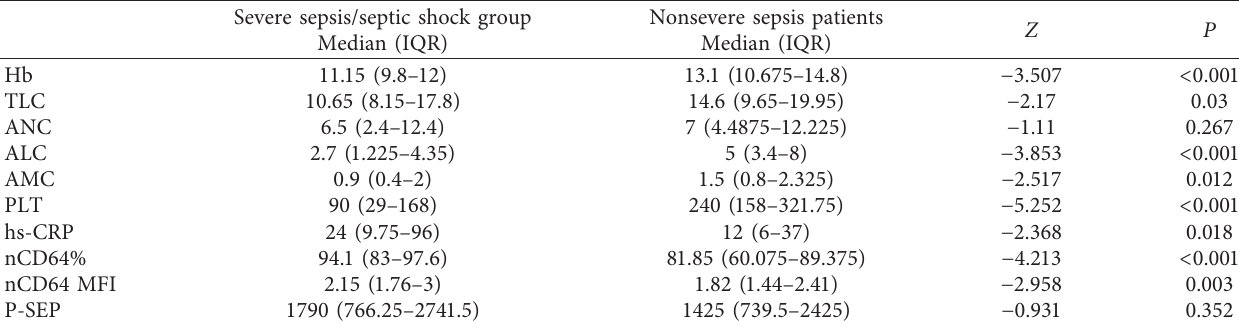
Table 4: Comparison between severe sepsis/septic shock patients and nonsevere sepsis patients.